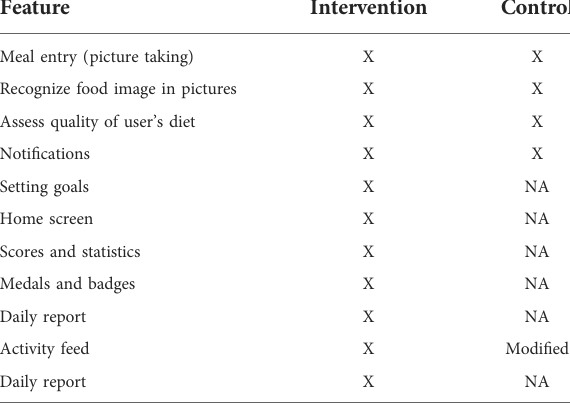
TABLE 1 Features of FRANI by intervention group in the fi rst four weeks of the pilot